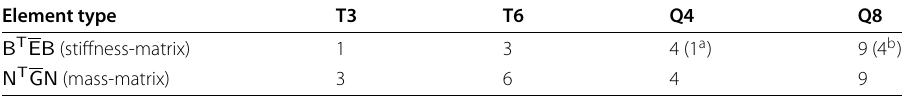
Table 1 The number of Gauss integration points for considered element types according to [21, Fig. 6.22], [20, Table 5.9] Element type